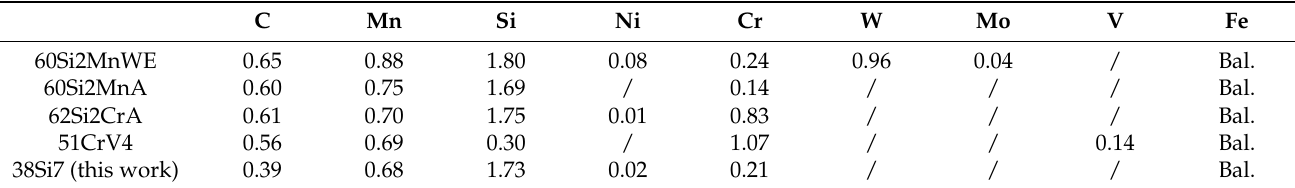
Table 1. The chemical composition of some spring steels